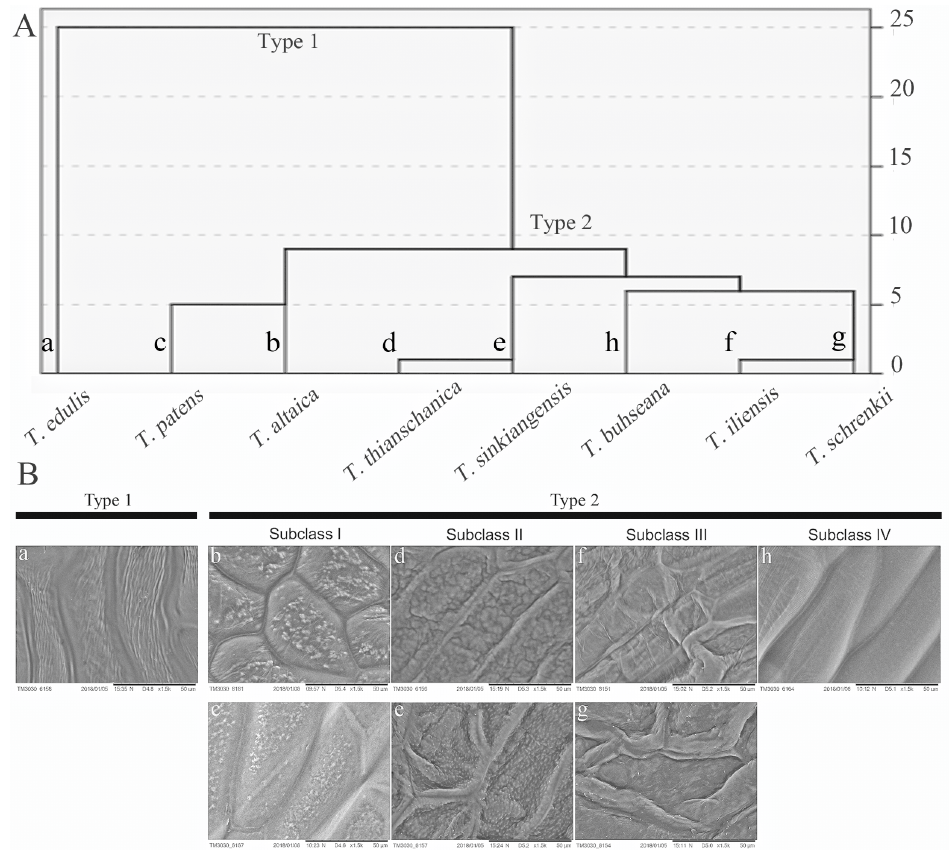
Figure 2. The cluster analysis of eight wild Tulipa species native to China. Bar = 50 µ m. ( A ). the cluster results ( B ). seed coat micromorphology observed by SEM; ( a ) to ( h ) in turn represent respectively T. edulis , T. patens , T. buhseana , T. altaica , T. thianschanica , T. sinkiangensis , T. iliensis , and T. schrenkii.